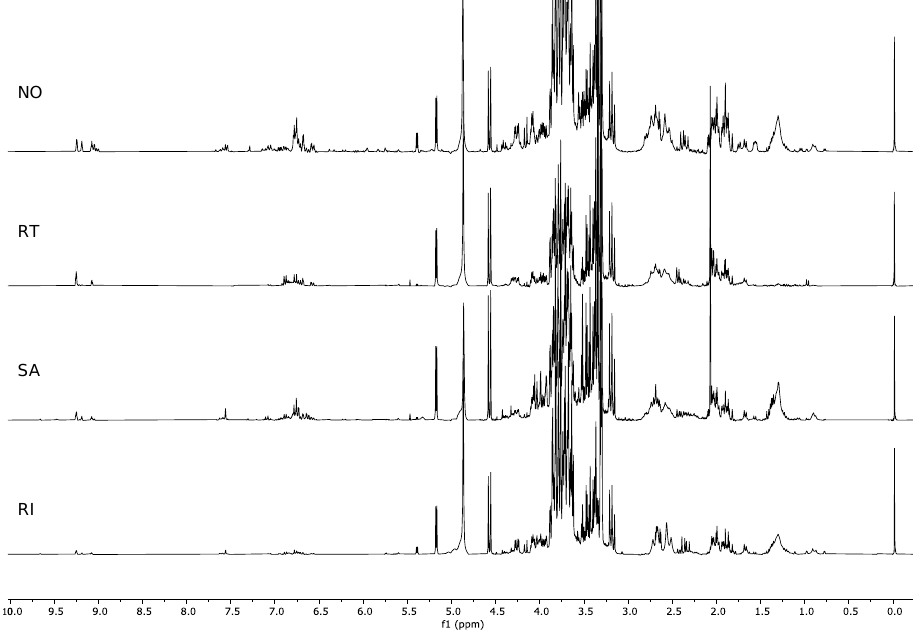
Figure 3. 1 H-NMR spectra of Group I: Ricippudda (RI), Salella (SA), Rotondella (RT), and Nostrale (NO).